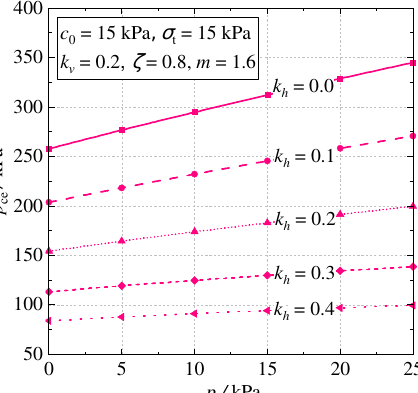
Figure 8. Seismic bearing capacity versus equivalent surcharge and horizontal seismic coefficient.